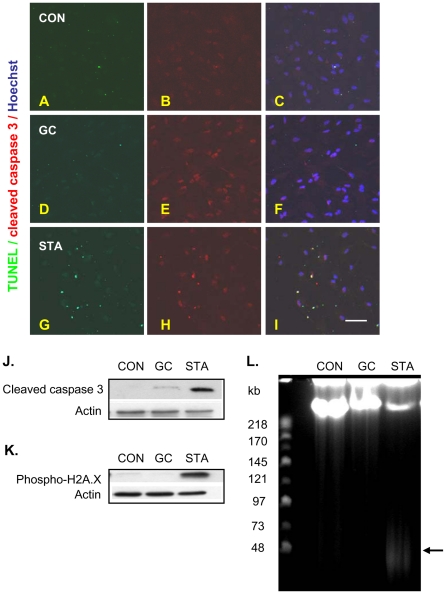
Enriched astrocytic cultures also respond to GC with moderate activation of caspase 3, but fail to show signs of early- or late-stage apoptosis.After re-plating, enriched astrocytic cultures were treated with GC (48 h) in medium containing either charcoal-stripped serum (data not shown) or B27 supplement (representative images in A–L). Enriched astrocytes responded to GC treatment DEX with moderately increased immunostaining for activated caspase 3; these cells did not enter late-stage (stage II) apoptosis, as shown by TUNEL (A–F). In contrast, staurosporine (STA) induced a marked activation of caspase 3 and apoptosis (G–I). The immunocytochemical results shown for activated caspase 3 in A–I were confirmed by immunoblotting (J). Staurosporine, but not GC, treatment of enriched astrocytic cultures significantly increased levels of immunoreactive phospho-H2A.X, a marker of early apoptosis, as shown by immunoblotting studies (K). Similarly, astrocytes exposed to STA, but not GC, displayed high molecular weight (HMW) DNA fragments, when lysates where subjected to pulse-field gel electrophoresis (PFGE) (L); all lanes were loaded with DNA from the same number of astrocytes, and arrow indicates 50 kb HMW DNA fragments. Scale bars: 50 µm.